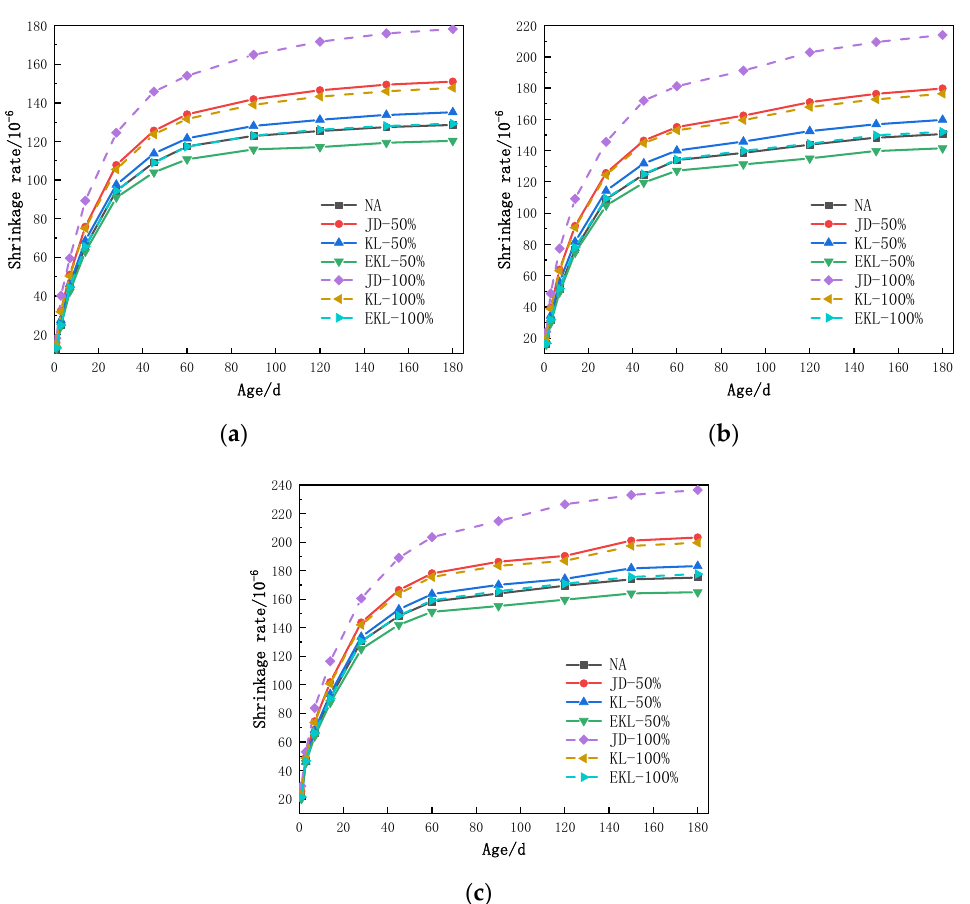
Figure 7. Effect of RCA quality and the replacement ratio on drying shrinkage of HBRAC: ( a ) cementitious material content 300 kg/m³, ( b ) cementitious material content 400 kg/m³, and ( c ) cementitious material content 500 kg/m³.